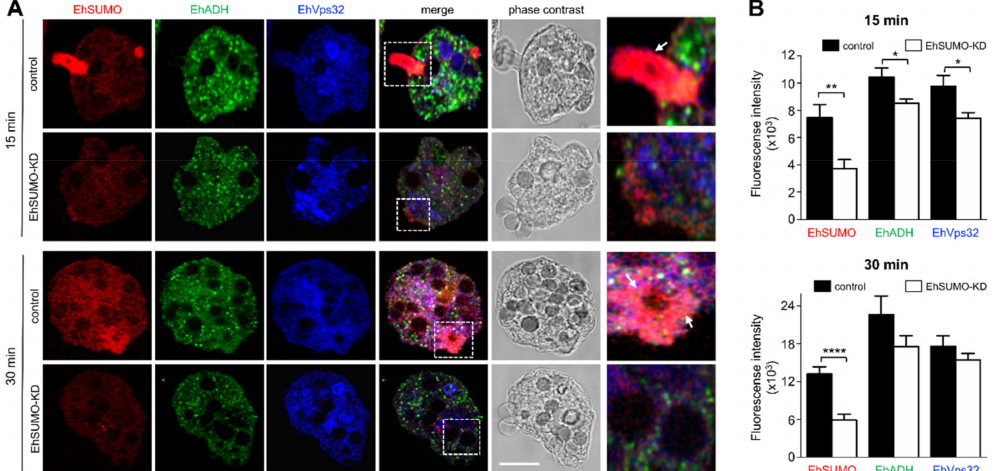
Figure 13. Localization of EhSUMO, EhADH, and EhVps32 in EhSUMO -KD trophozoites during phagocytosis. Ery- throphagocytosis kinetics of trophozoites silenced using the PL4440/ EhSUMO plasmid. ( A ) Representative image of control and EhSUMO -KD trophozoites at 15 and 30 min of phagocytosis using α -EhSUMO (red), α -EhADH (green), and α -EhVps32 (blue) antibodies and analyzed by confocal microscopy. Scale bar = 10 µ m. Right panels: Magnification of squares in merging images. Arrows: phagocytic channel and areas around erythrocytes. ( B ) Fluorescence intensity measured by pixels and corresponding to EhSUMO, EhADH, and EhVps32 proteins in both types of trophozoites at both times of phagocytosis. (*) p < 0.05, (**) p < 0.01 and (****) p <